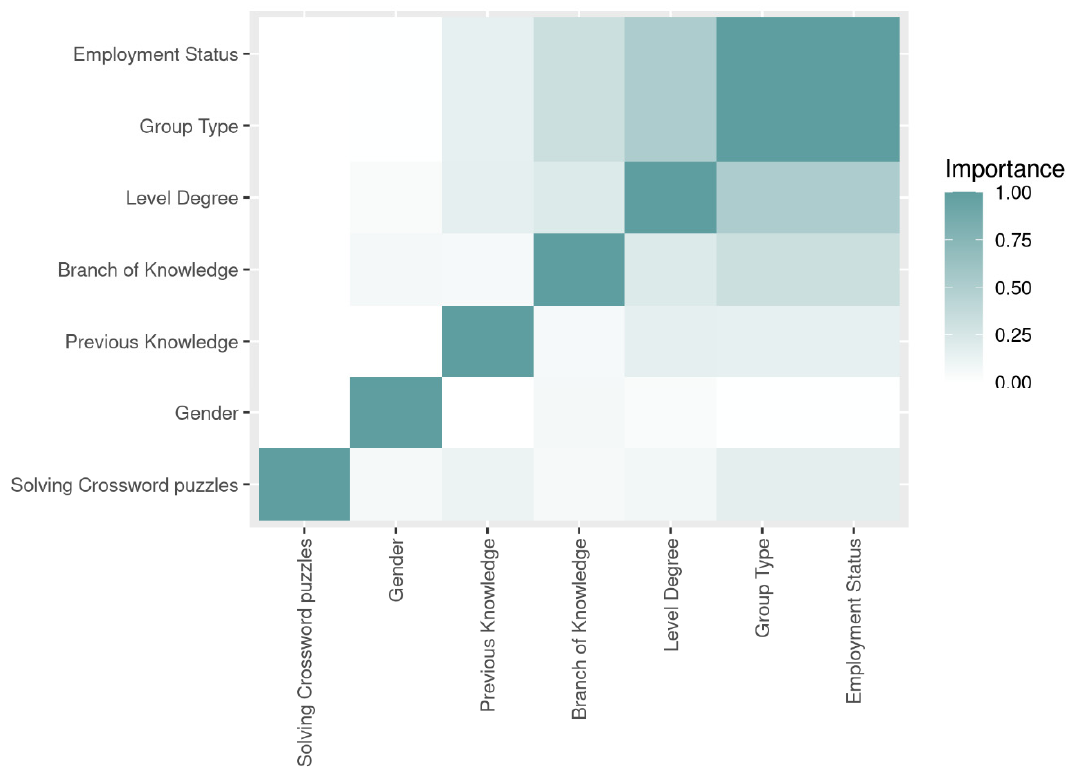
Figure 5. Relationship matrix on the selected features performed with the symmetrical uncertainty